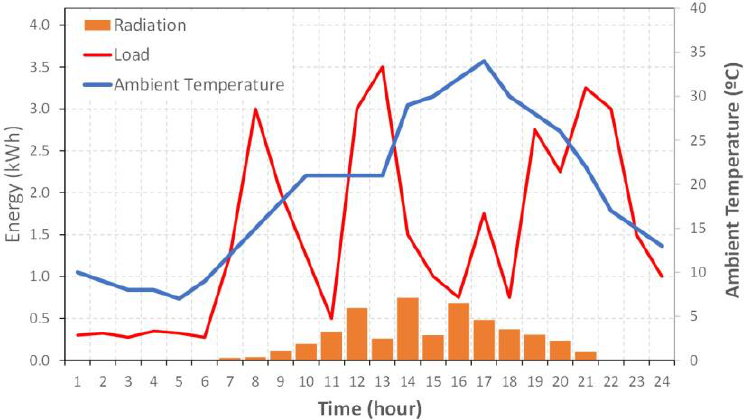
Figure 4. Solar Irradiance, ambient temperature, and load demand profiles for the selected day.